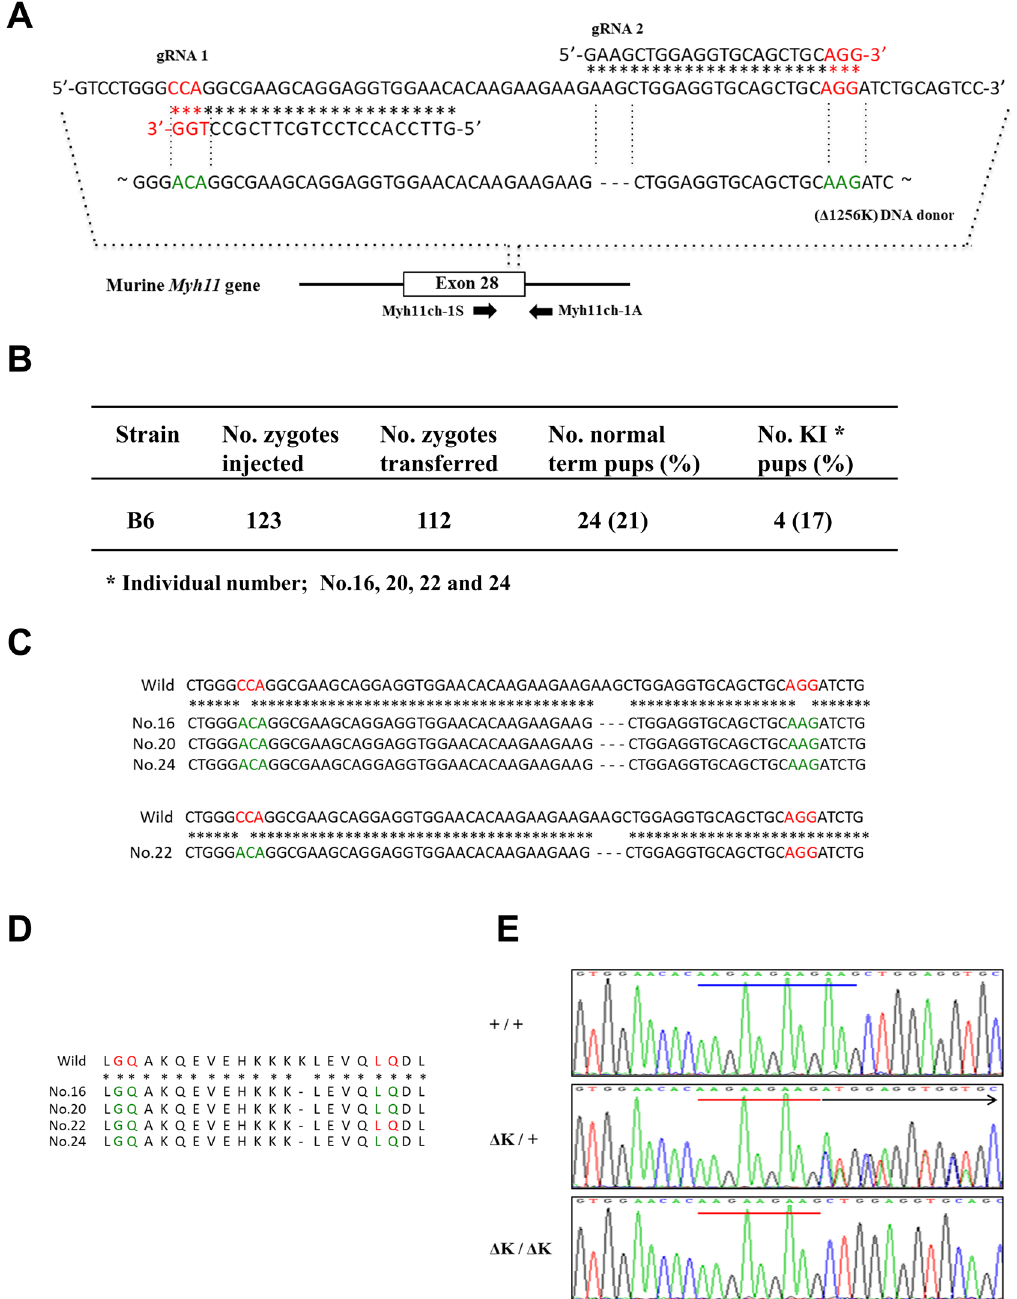
Figure 1. CRISPR/Cas9-based generation of Myh11 (Δ1256K) mice. (A) Sequence of exon 28 of murine Myh11 to which both gRNA1 and 2 bind and an Myh11 (Δ1256K) DNA donor targeting site. The PAM and modified PAM sequence site in the Myh11 (Δ1256K) DNA donor fragment are indicated by red and green, respectively. Locations of PCR primers are indicated by arrows. (B) Table summarising the number (no.) of zygotes injected, no. zygotes transferred and no. zygotes developed to full term is shown. The no. of pups showing knock-in is also shown. (C) Sequences around the Myh11 target site in wild-type (WT) and knock-in samples (nos. 16, 20, 22 and 24). Upper panel shows sequences with the deletion of AAG alone and those in which both PAM sequences (red) were changed to modified PAM sequences (green) in the samples numbered 16, 20 and 24. Lower panel shows the sequences showing the deletion of AAG alone and those in which only a PAM sequence recognised by gRNA1 (red) was changed to modified PAM sequences (green) recognised by gRNA1 in the sample numbered 22. (D) Amino acid sequences around the Myh11 target site of WT and knock-in samples (nos. 16, 20, 22 and 24). Note that the sequences of all knock-in pups are the same as those of the WT pups except for the absence of lysine (K) in knock-in pups. Red shows amino acids corresponding to WT PAM sequences. Green shows amino acids corresponding to modified PAM sequences. The no. 22 line with WT PAM sequences recognised by gRNA2 was selected for further analysis because its alleles are close to the WT Myh11 allele. The no. 22 line was backcrossed to B6 background through passing 2 generations. (E) Myh11 (Δ1256K) genotyping of the no. 22 line by direct sequencing of PCR products corresponding to the Myh11 target site. The blue line shows AAG × 4, the red line shows AAG × 3 and the arrow shows the start of error